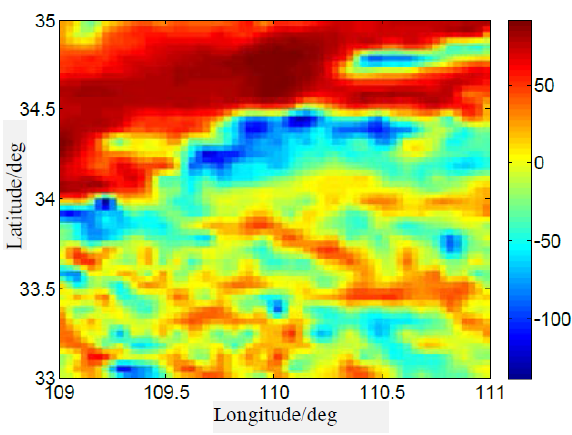
Fig. 3. stds of δg component difference between classical Stokes integral values and true values